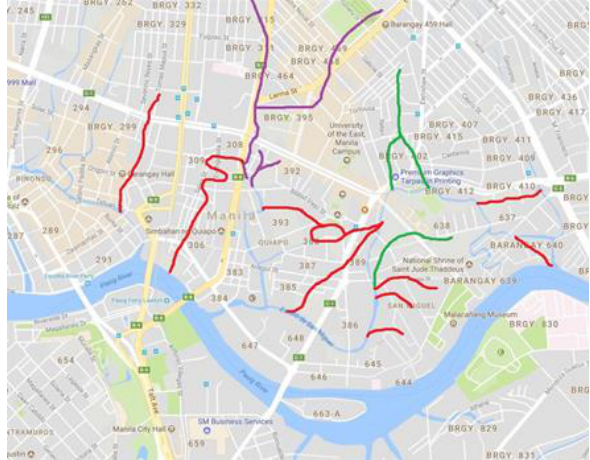
Figure 4. Detected changes in waterways around Manila: Red - disappeared, Green - still present, Violet - possibly underground.